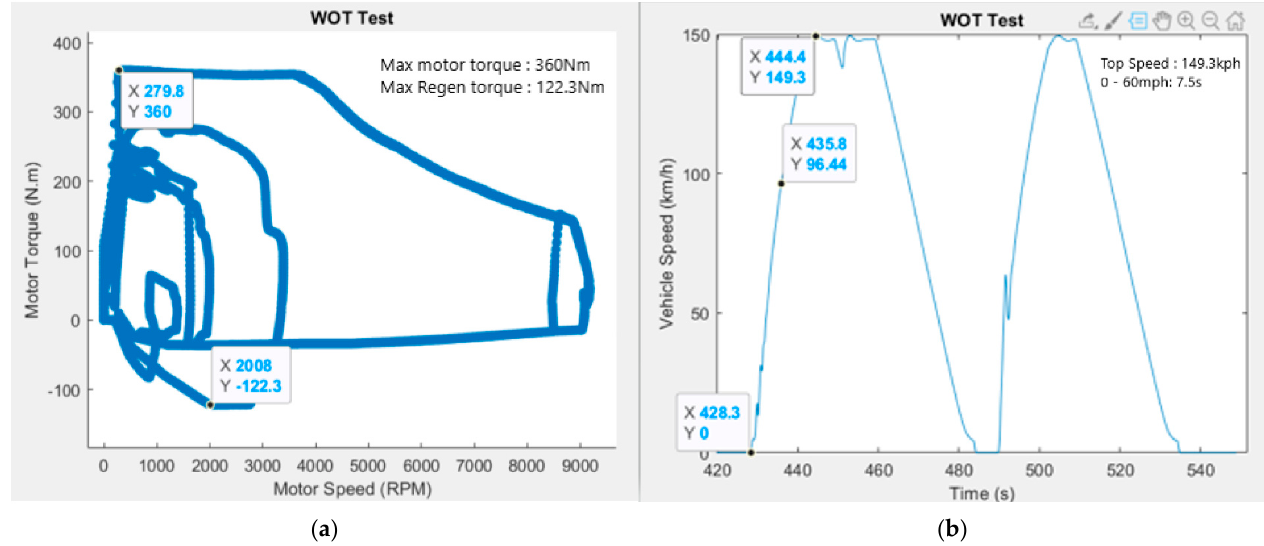
Figure 19. Wide-open throttle (WOT) test ( a ) motor torque envelope ( b ) vehicle speed Adapted from [18], IEEE: 2020.